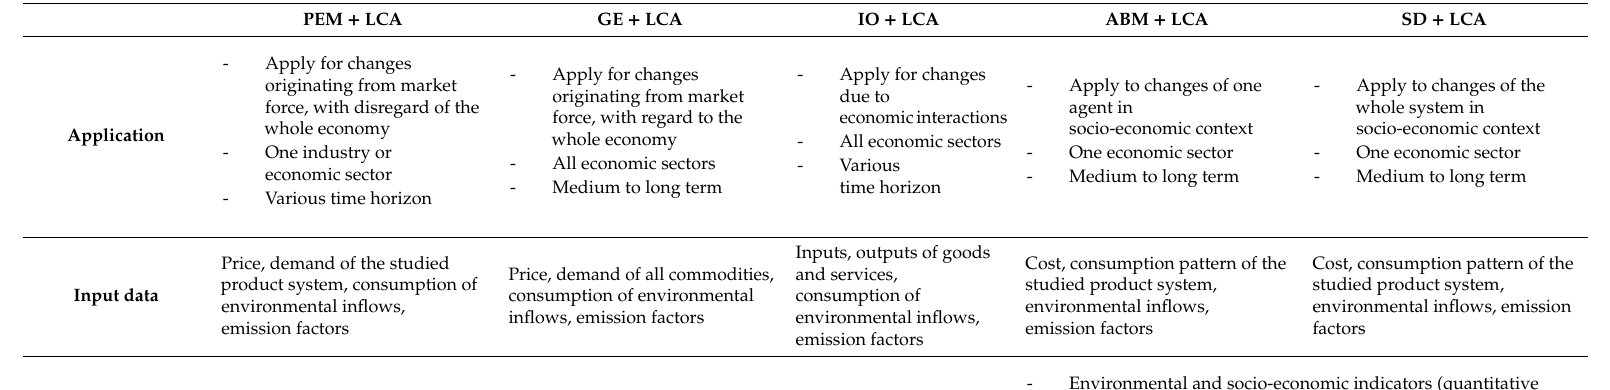
Table 1. Features of the models for consequential life cycle assessment